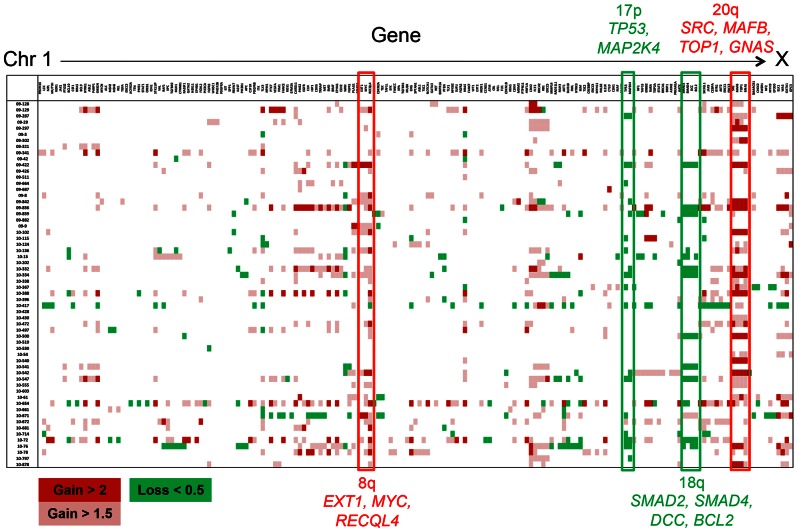
Copy number variation table.Samples are aligned according to sample identification number in the Y-axis and genes are aligned according to chromosomal location in the X-axis.